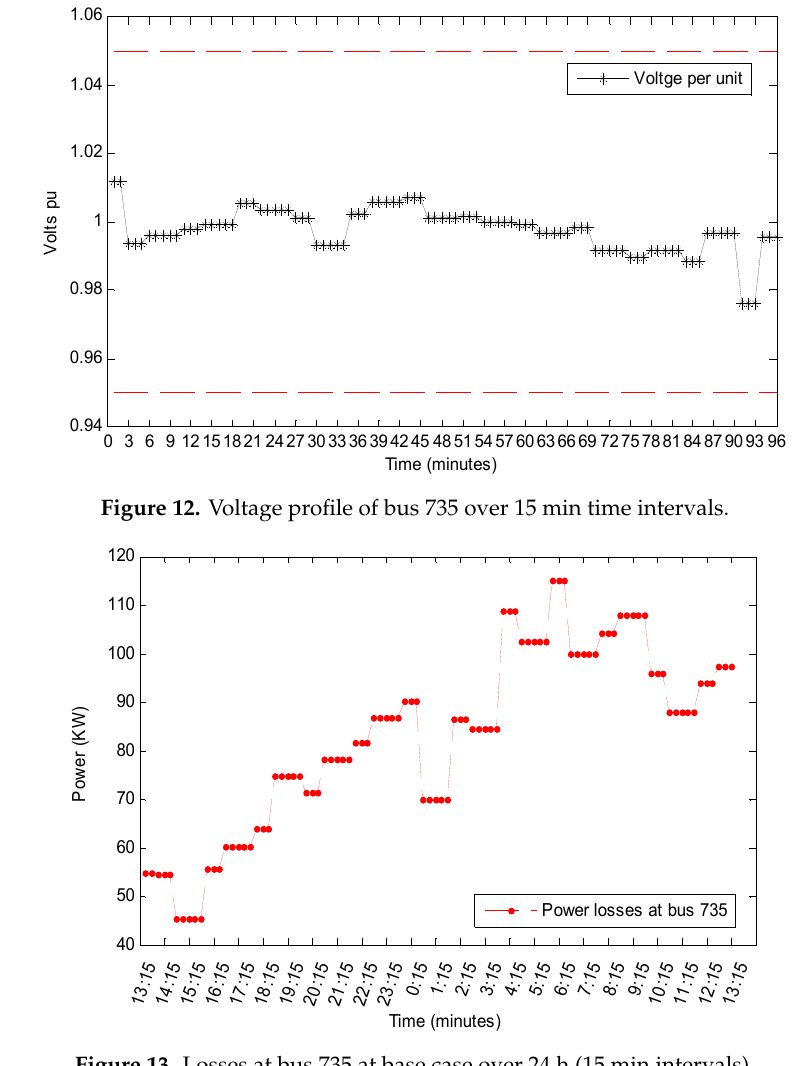
Figure 13. Losses at bus 735 at base case over 24 h (15 min intervals).